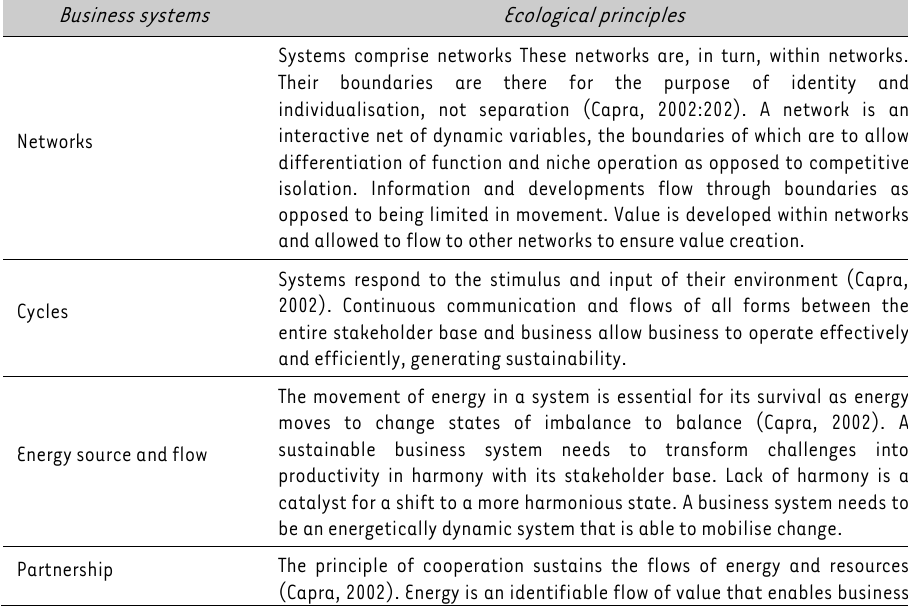
Comparison of ecological principles to business